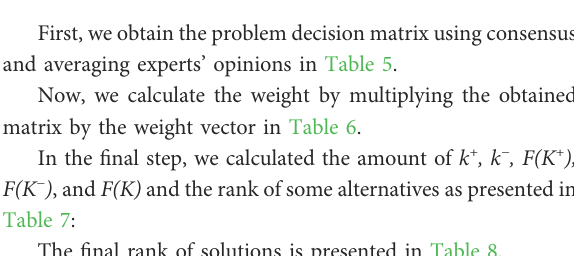
The fi nal rank of solutions is presented in Table 8.